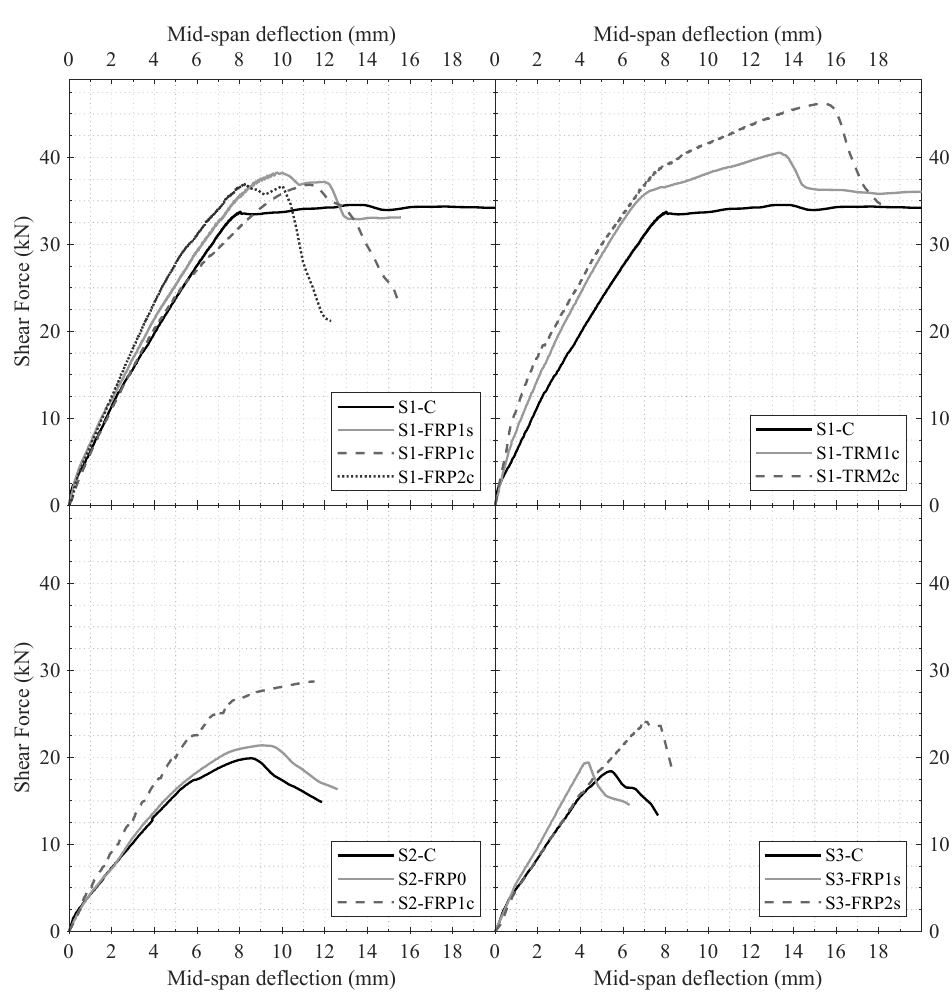
Figure 4. Shear force vs mid-span deflection for all tested specimens.